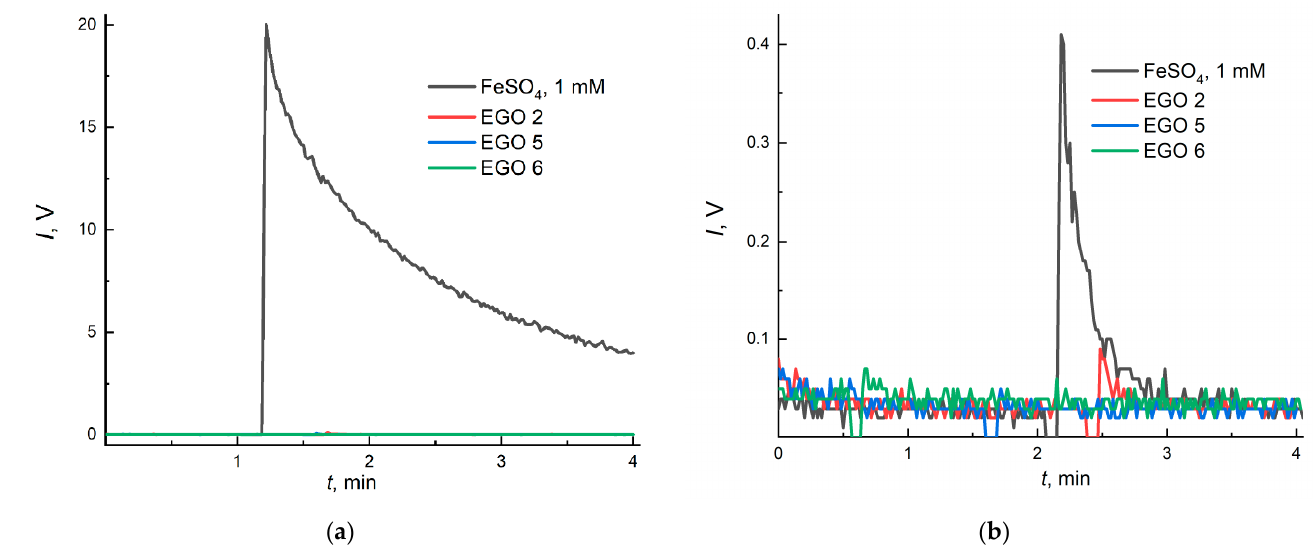
Figure 9. Chemiluminograms of peroxidation ( a ) lipids in a system of linoleic acid (5 mM, 25 µL), coumarin C-334 (5 mM, 10 µL), and Fe(II) (20 mM, 50 µL); ( b ) phospholipids in a system of phosphatidylcholine hydroperoxide (28 mM, 50 µL), coumarin C-334 (5 mM, 10 µL), and Fe(II) (20 mM, 50 µL). In all cases, ca. 3.5 ppm EGO was added (50 µL).